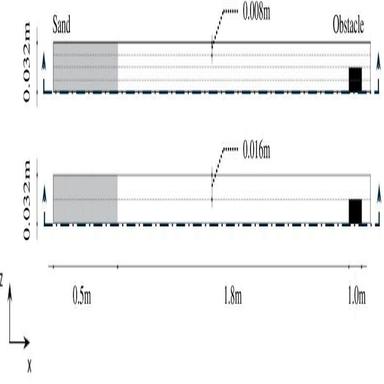
Plan view of the simulated flume with 4 and 2 segments along z, for 50% obstruction.